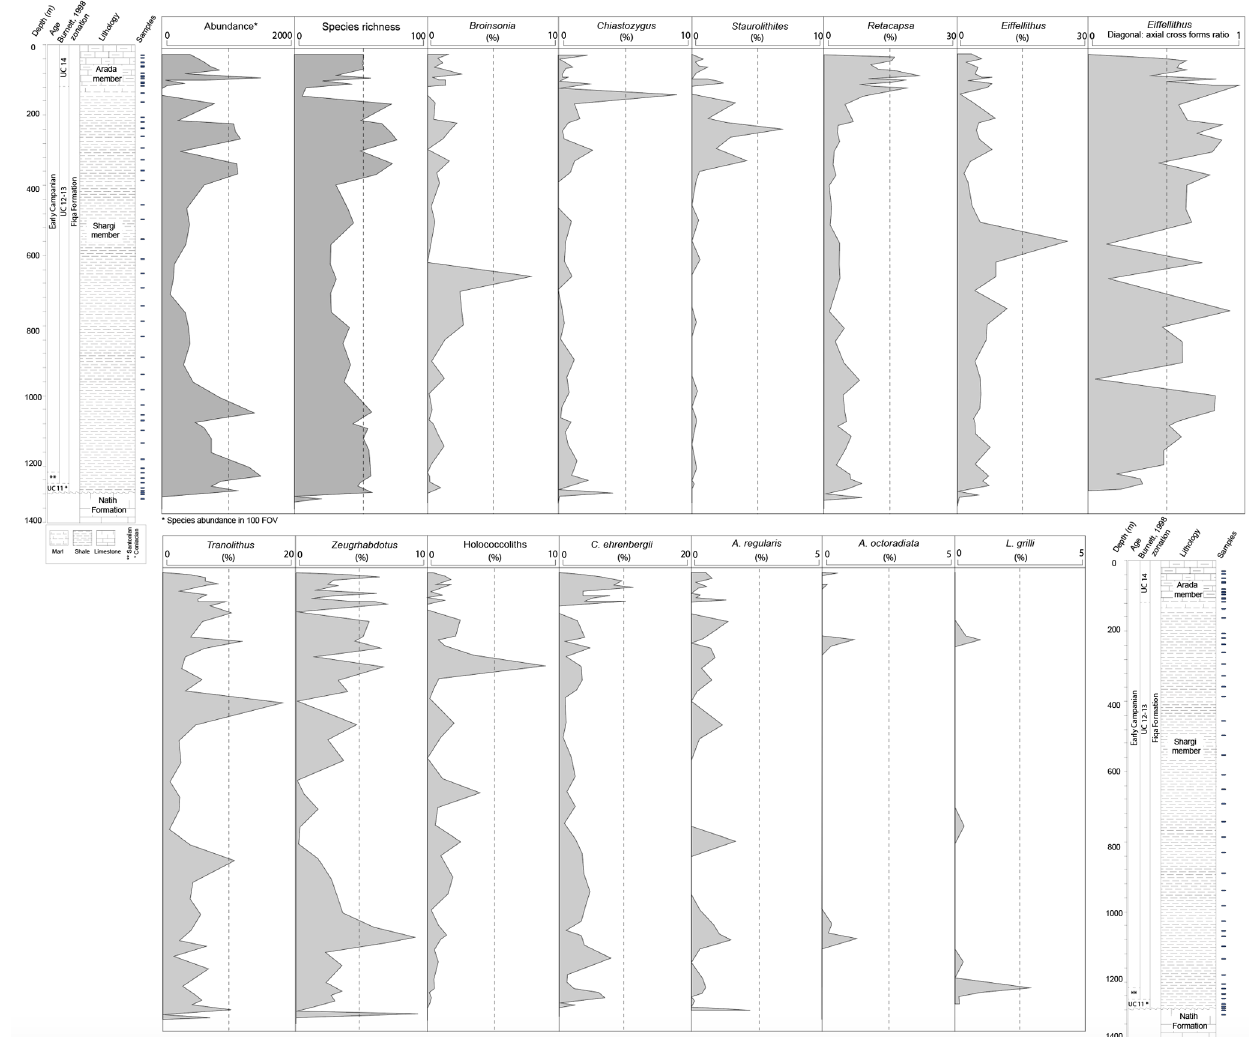
Figure 4. Abundance distribution patterns of the main components in the nannofossil assemblages,